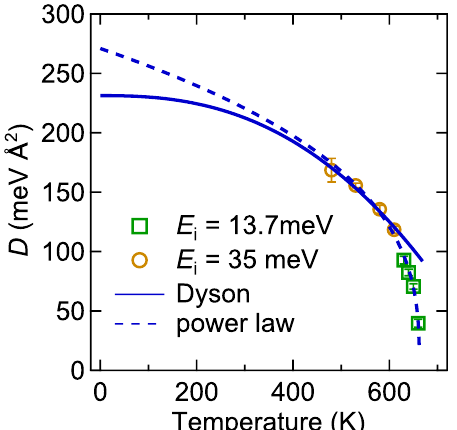
Figure 3. The temperature dependence of the spin wave stiffness parameter, D ( T ) . Data from both the E i = 13.7 meV and E i = 35 meV experiments were included in the power law fit, D ( T ) = (cid:16) (cid:17) ν − β T C − T D 0 , shown as the dashed line. Only the lowest four temperatures were used in the Dyson T C (cid:20) (cid:17)(cid:21) (cid:16) (cid:17) 5/2 (cid:16) k B T 5 ζ 1 − A , shown as the solid fit, D ( T ) = D 0 2 4 π D 0